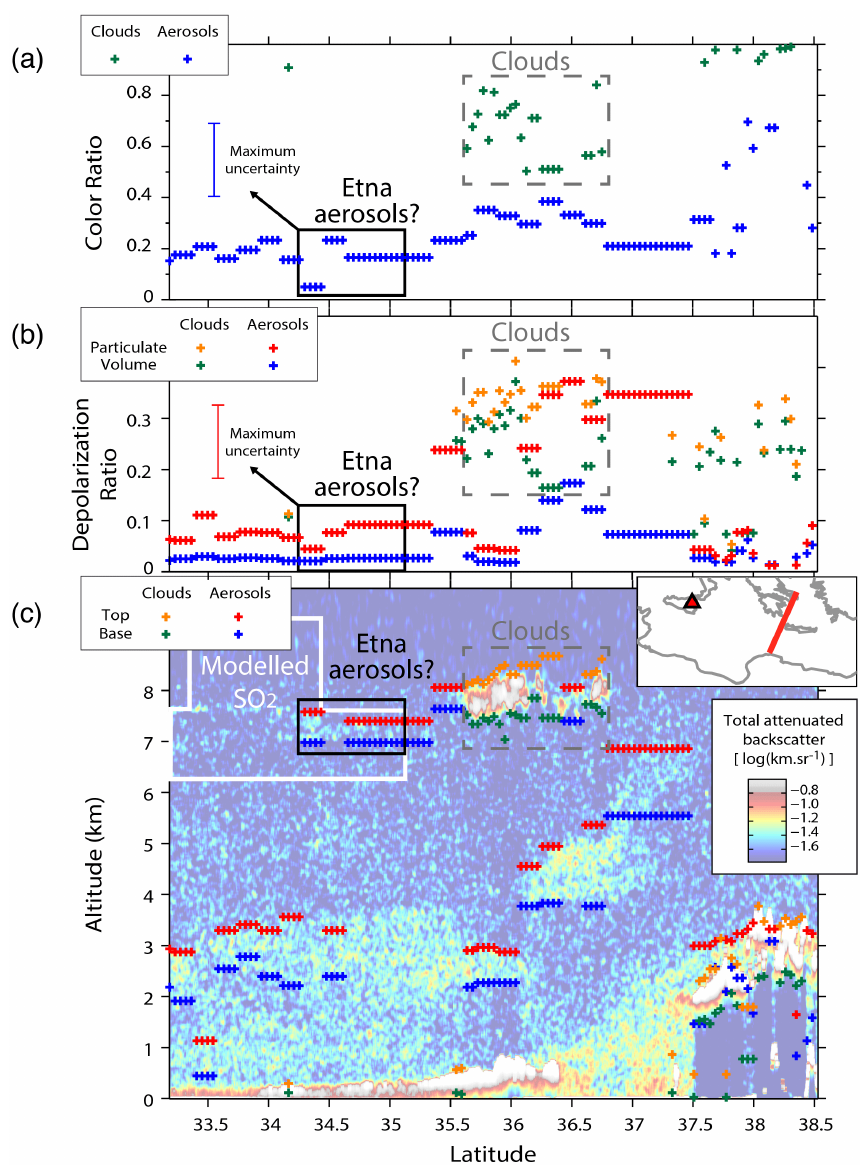
Figure 9. CALIOP track crossing the Etna volcanic cloud on 11 April 2011 00:27UT. (Bottom) Altitude (top and base) of the highest layer of aerosols (blue, red) or meteorological clouds (green, orange) retrieved from Level 2 CALIOP analysis is superimposed on the total attenuated backscatter signal at 532nm. White, black and dashed contours indicate respectively Etna modelled SO 2 , collocated aerosols and neighbour meteorological clouds. (Middle) Volume and particulate depolarization ratios for aerosols (blue, red) or clouds (green, orange). Maximum uncertainty on particulate depolarization ratios of Etna aerosols is indicated (uncertainties on volume depolarization ratios are smaller than symbol size). (Top) Total colour ratio for aerosols (blue) or clouds